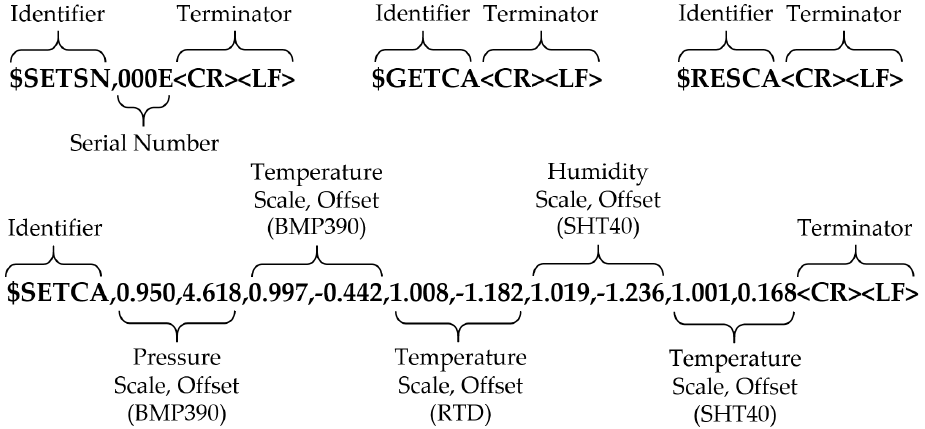
Figure 4. Example formatted strings received by the PTH probe from the host over 3.3 VDC TTL UART. The PTH probe responded by echoing the string with relevant data and checksum inserted before the terminator.